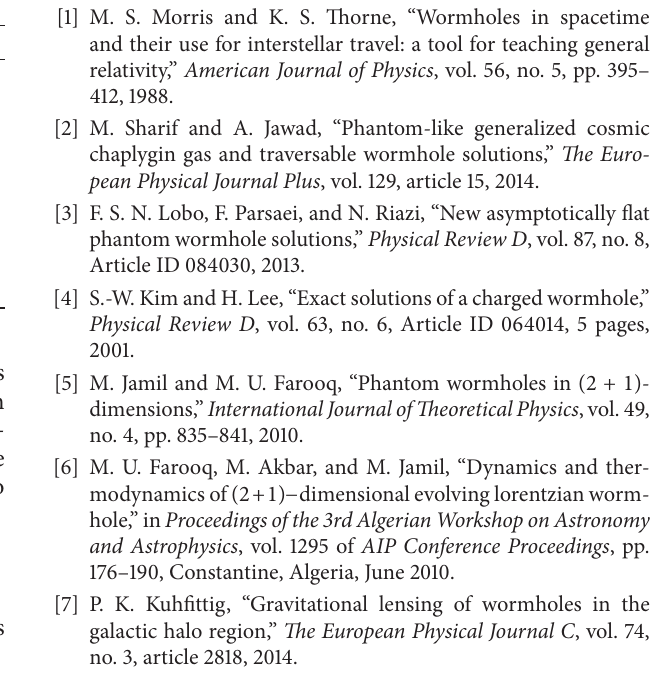
Table 4: Wormhole solutions with Lorentzian noncommutative background for 𝑠 −